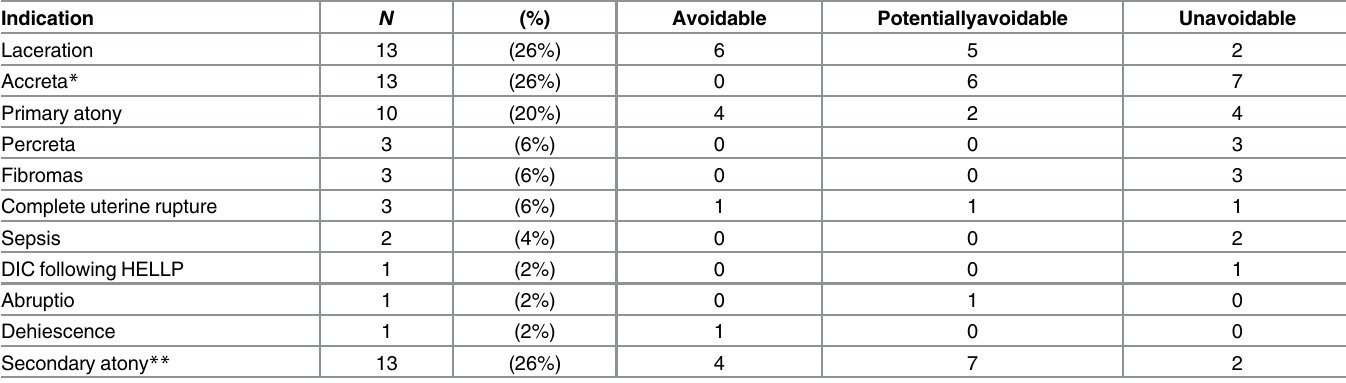
Table 1. Indications for hysterectomy and avoidability.